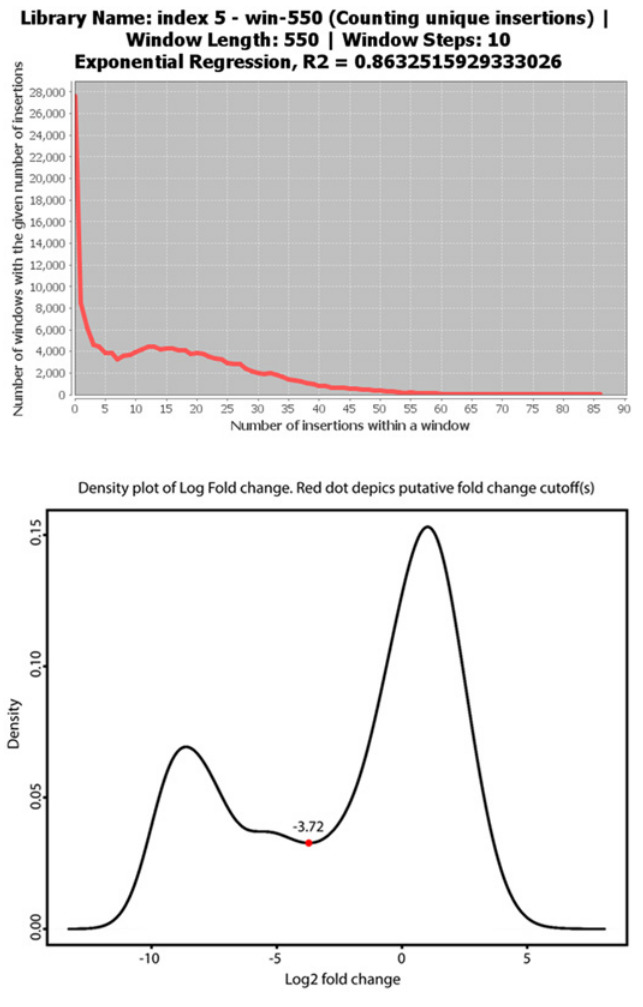
Fig 3. Distribution of counts of unique insertions in a sliding 550 bp window from Tn-seq Explorer (top) and distribution of LogFC values from the ESSENTIALS output.